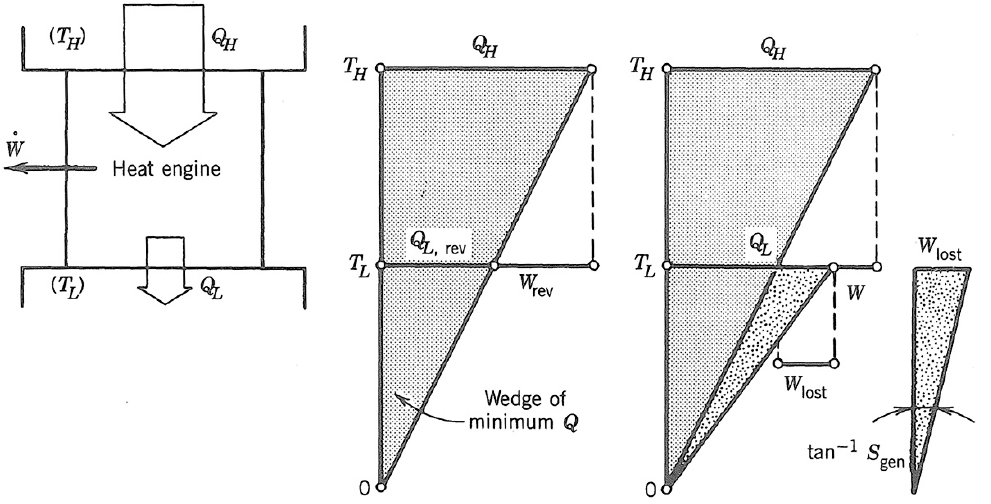
Figure 14. The temperature-heat (T-Q) graphic method [39,49,142] applied in this case to a closed system operating in cycles in communication with two temperature reservoirs (e.g., heat